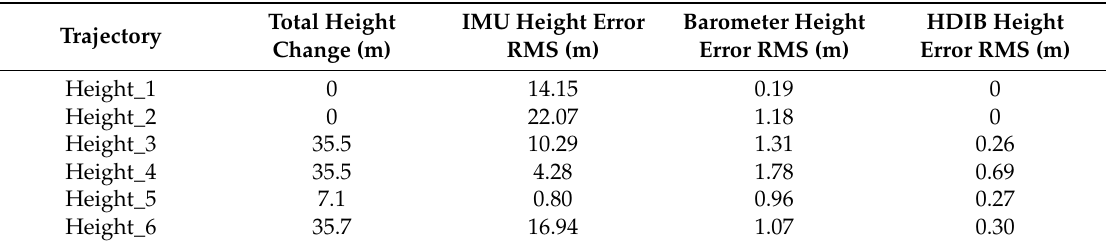
Table 7. RMS results of IMU based height estimation, barometer based height estimation and HDIB based height estimation.